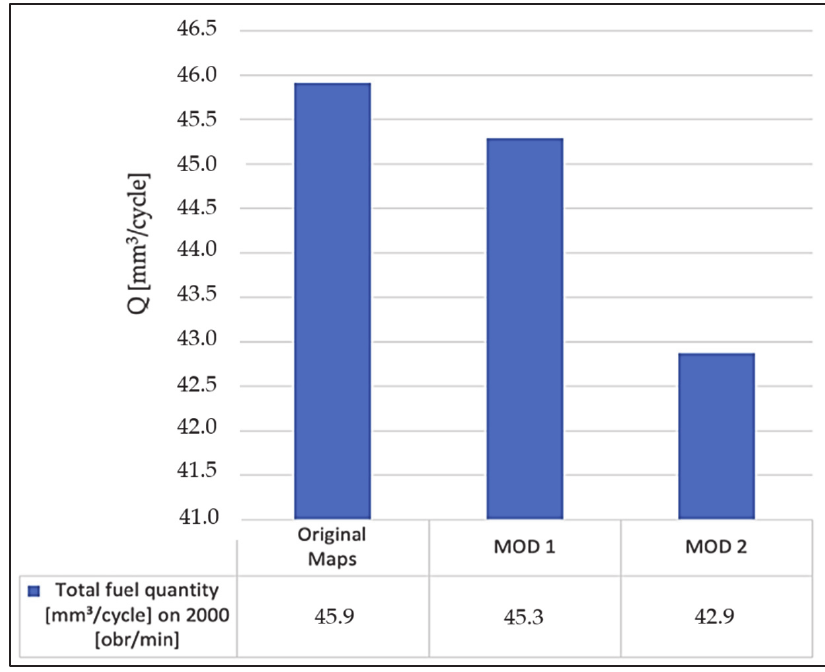
Figure 11. Total fuel quantity on 2000 RPM and 130 Nm.